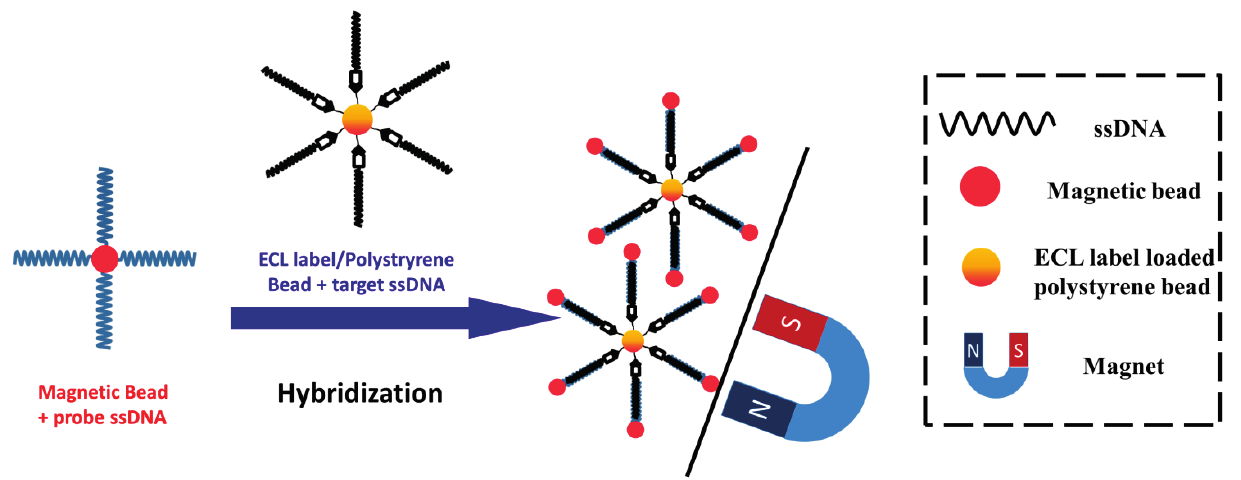
Figure 8. Schematic of two beads mode for ECL DNA detection. Reprinted with permission from ref. [175], copyright (2004) American Chemical